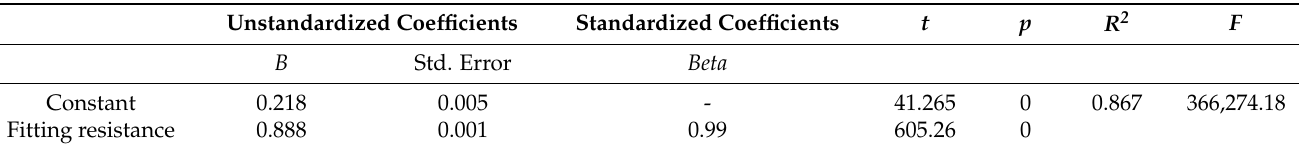
Table 4. Linear regression analysis of the three-dimensional equivalent resistance model and the actual